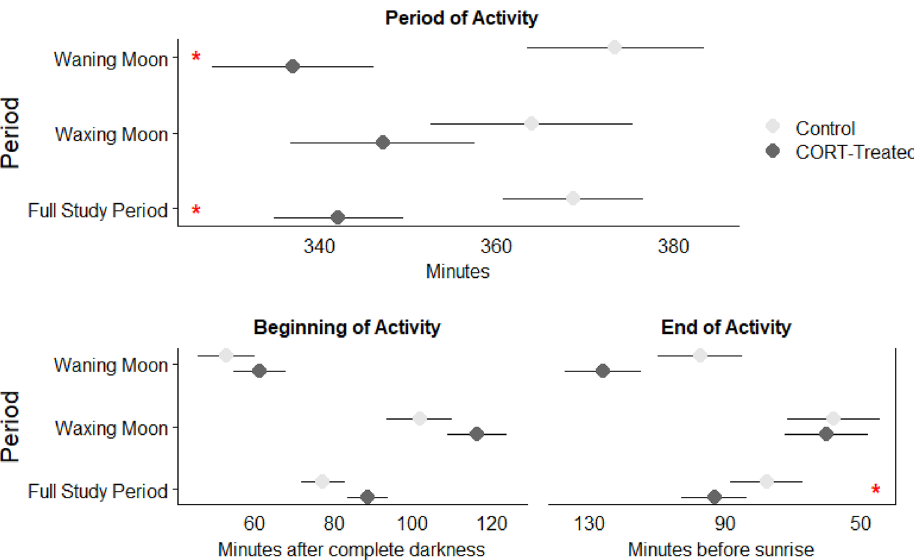
Figure 5. Timing of activity, defined as body temperatures ( T b ) within 0.5 °C of modal active body temperature, relative to periods of darkness. For example, control animals raised T b near modal active temperatures slightly earlier after both the sun and moon dropped below the horizon (complete darkness) and maintained high T b closer to sunrise than CORT-treated animals during the waning phase of the lunar cycle (bottom panels). While neither comparison alone was significantly different, the collective effect was a significantly longer active period for control animals (top panel). Asterisks represent comparisons between control and CORT-treated animals that are significant ( p < 0.05). Data are presented as least squares means estimates ± standard